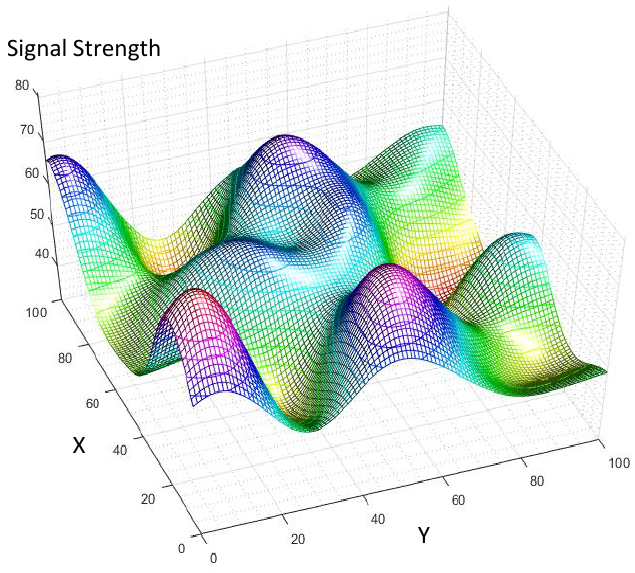
Figure 3. The synthetic correlated spatial signal is generated using the described model in (13).